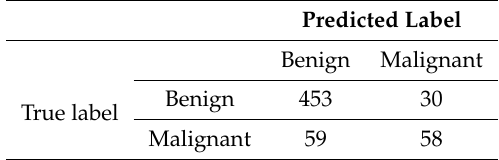
Table 8. Confusion matrix—TF + Rotation with data augmentation.